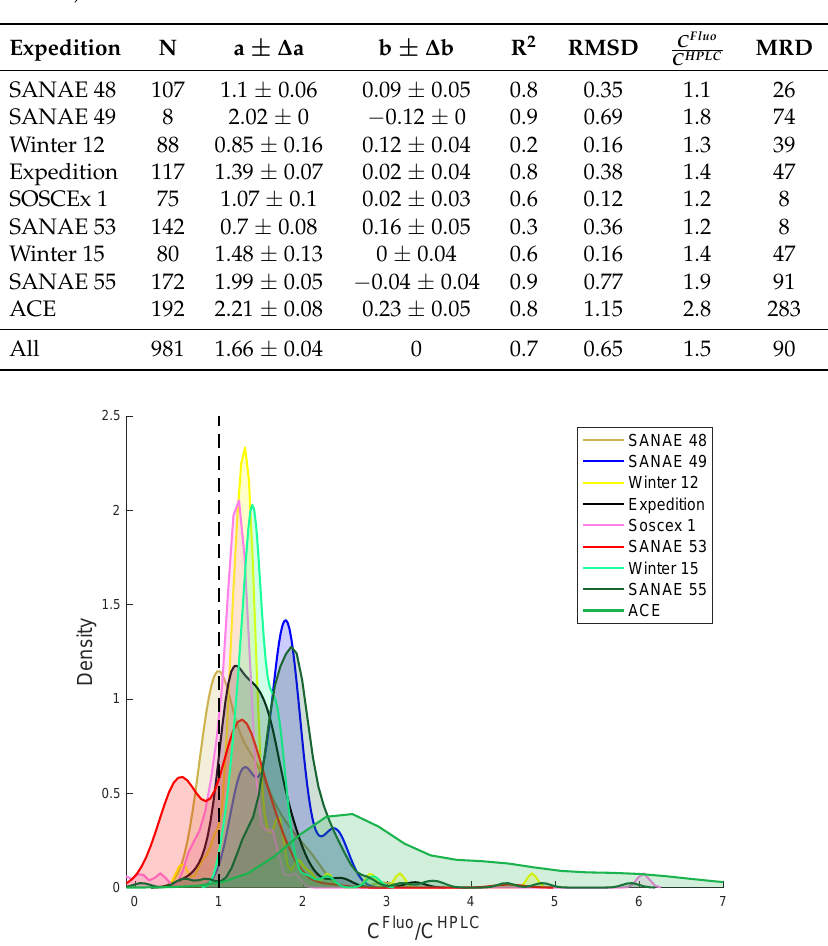
Figure 5. Probability density function of the ratio between chlorophyll-a measured from fluorometry (C Fluo ) and HPLC (C HPLC ). Each color corresponds to a specific